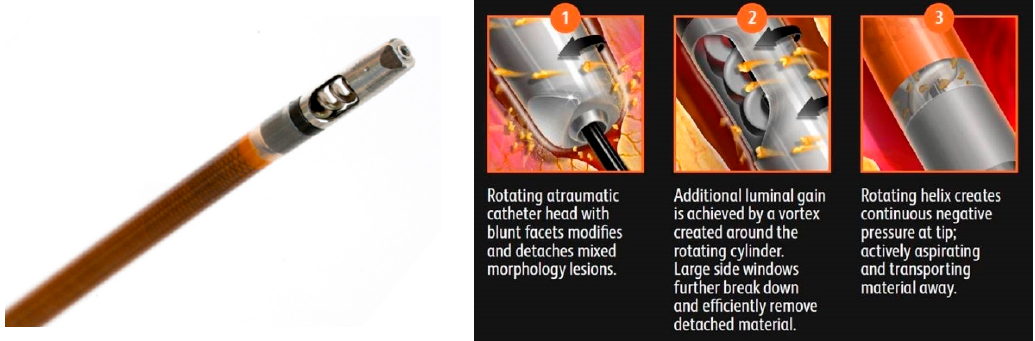
Figure 5. Rotarex Rotational Excisional Atherectomy System. Image 1 shows rotating atraumatic catheter head which modifies plaque and detaches mixed morphology lesions. Image 2 shows additional luminal gain achieved by vortex created around the rotating cylinder. Side windows break down and remove detached material. Image 3 shows rotating helix which creates continuous negative pressure at tip to actively aspirate and transport material away. Courtesy of BD BARD Peripheral Vascular.